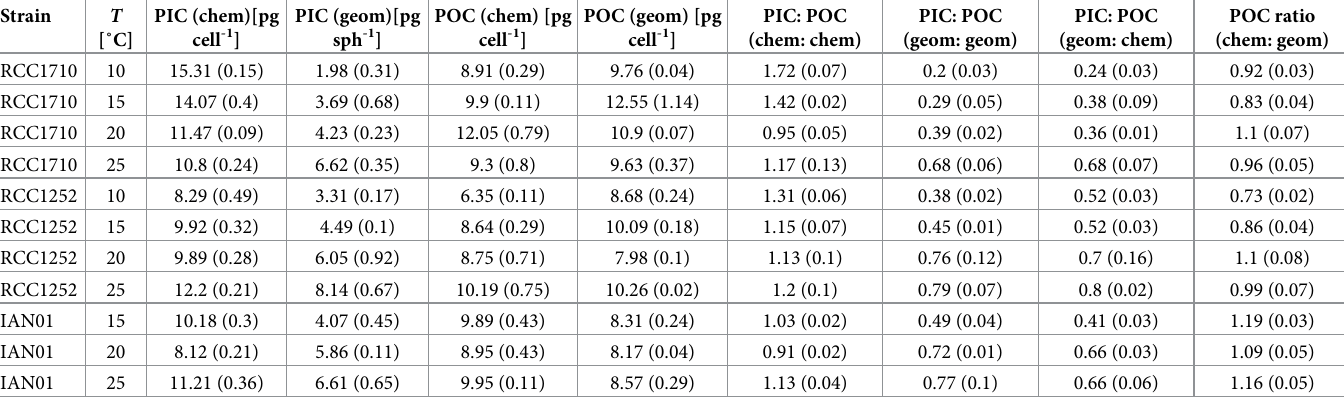
Table 4. Chemically (chem) and geometrically (geom) derived particulate inorganic carbon (PIC) and particulate organic carbon (POC).